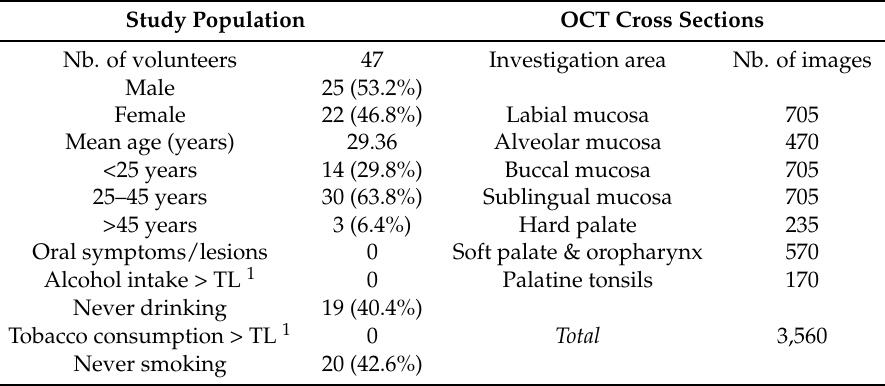
Table 2. Statistics on the study population and the amount of the OCT cross